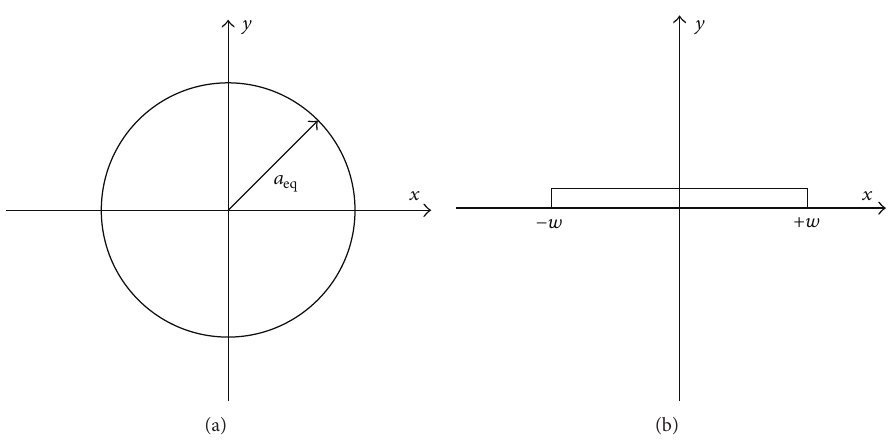
Figure 1: Schematic of cross section for thin-wire dipole antenna and microstrip dipole antenna.